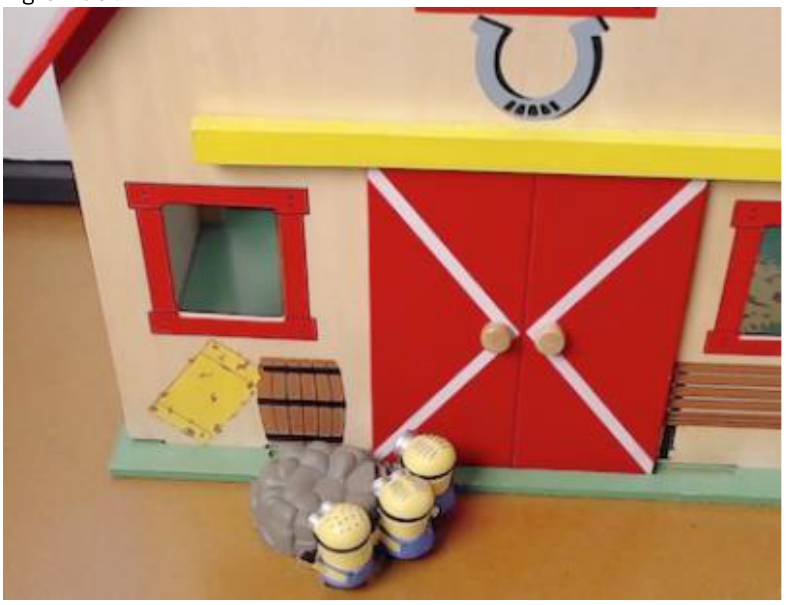
Figure 3. Image of the Last Scene of a Collective Scenario, in Which All Three Minions Push a Single